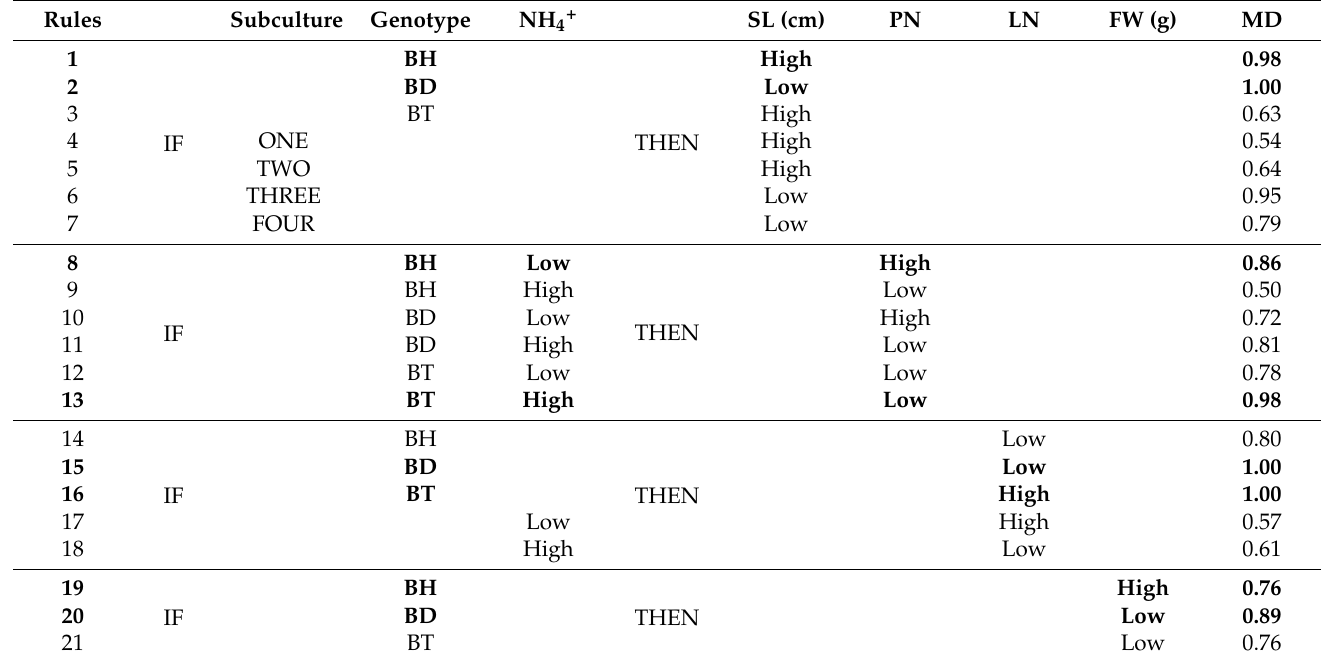
Table 3. Rules selection obtained by neurofuzzy logic. Bold letters indicate input/s with the strongest effect on low and high values for each output. MD, membership